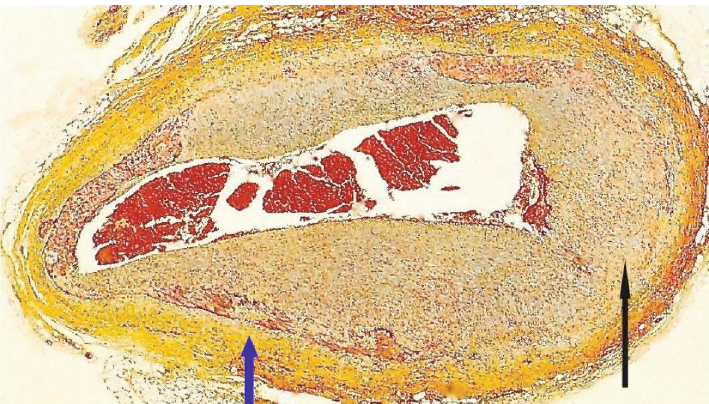
Figure 18: Segmental arterial mediolysis reparative phase. The black arrow points to thick mature granulation tissue fi lling a large gap aneurysm. The blue arrow shows extended intimal plaque bedecking a medial island that show foci of medial loss with reparative fi brosis. Another granulation tissue gap repair is evident in the upper portion of the artery, Movat stain × 25.